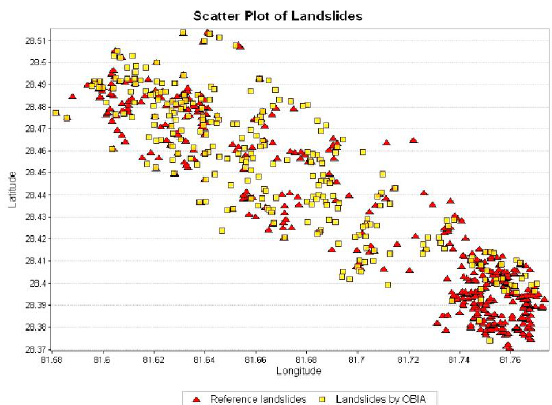
Figure 7. Spatial distribution of OBIA extracted landslides and reference landslides